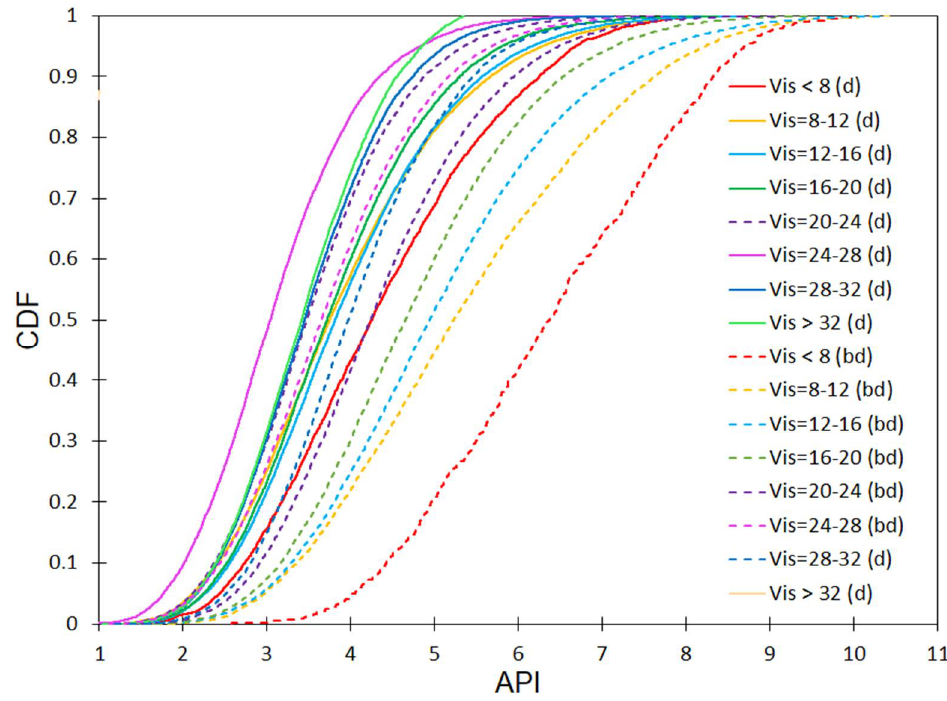
Figure A5. Effect of spring visibility on Air Pollution Index (API) (where: d—rainy period, bd—dry period).